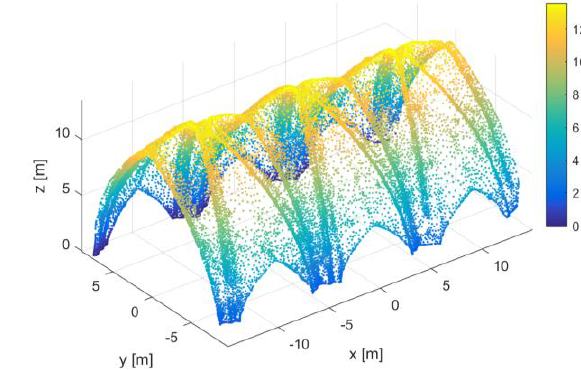
Figure 2. St. Bassiano Church: Point cloud of vault in the nave